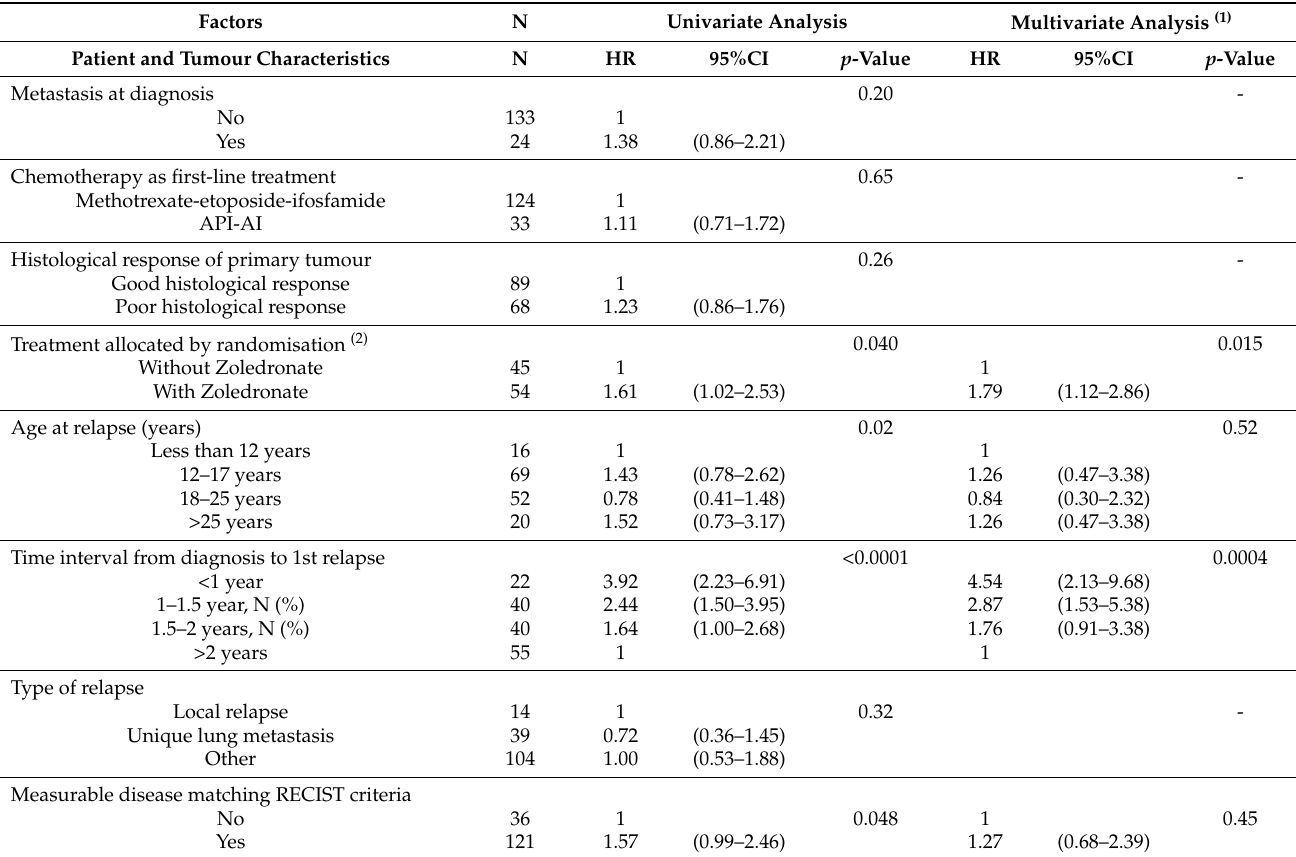
Table 3. Prognostic factor study of the progression free survival after first